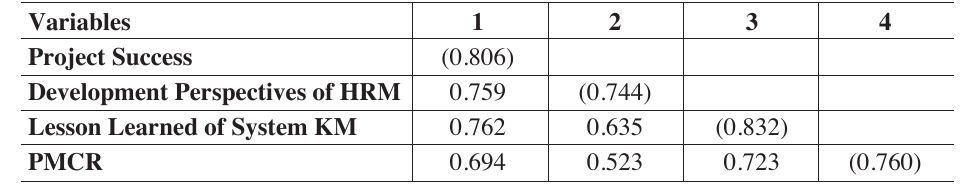
Table 3: Discriminant Validity